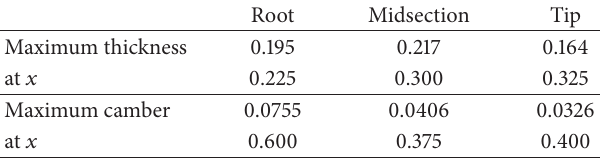
Table 2: Maximum thickness and camber and their respective locations on the unit-length chord of each blade section at three radial positions: root, midsection, and tip of the aerodynamic